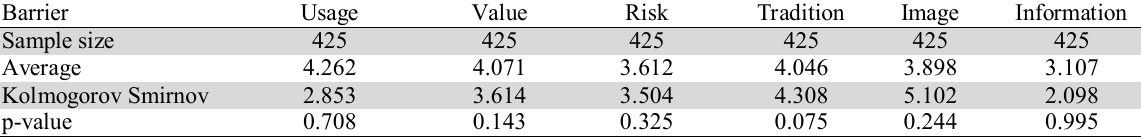
The results of Kolmogorov Smirnov for data normality test Barrier Usage Value Risk Tradition Image Information Sample size 425 425 425 425 425 425 Average 4.262 4.071 3.612 4.046 3.898 3.107 Kolmogorov Smirnov 2.853 3.614 3.504 4.308 p-value 0.708 0.143